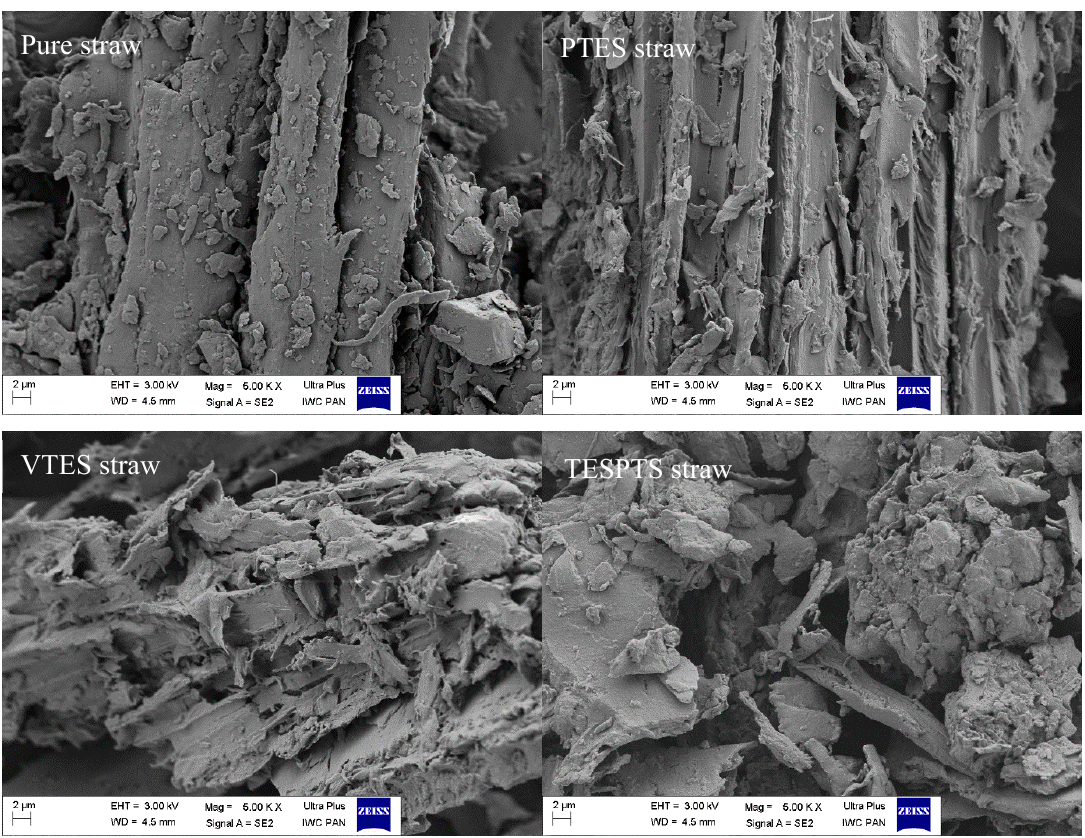
Figure 3. SEM images of ground straw (modified and unmodified) under magnification 5000×.